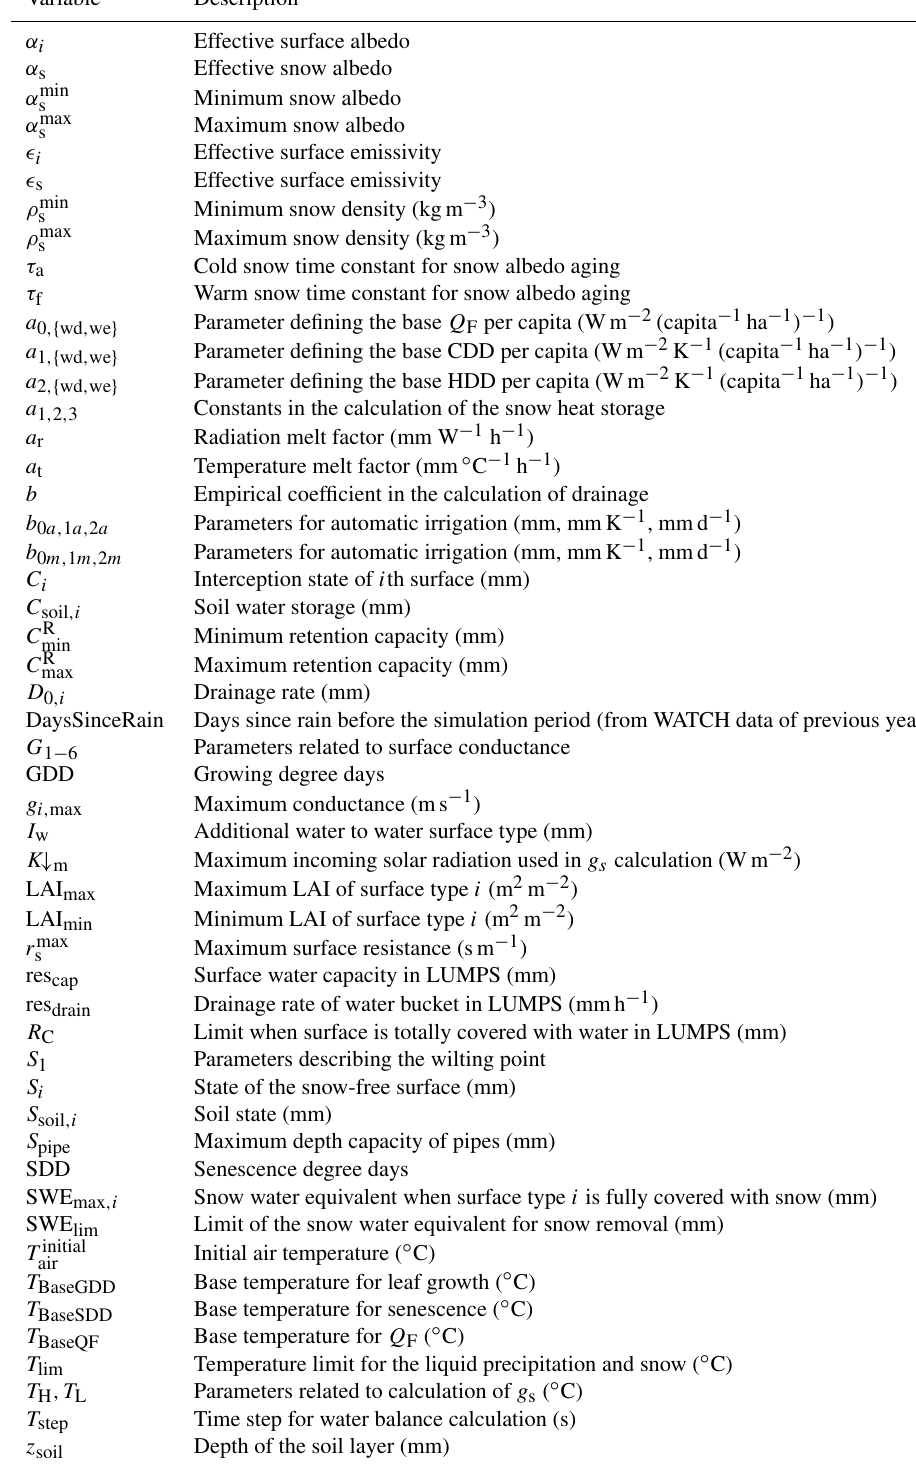
Table A1. Notation used in Tables 1 and A2. Details and sources of the values are given in Järvi et al. (2011,